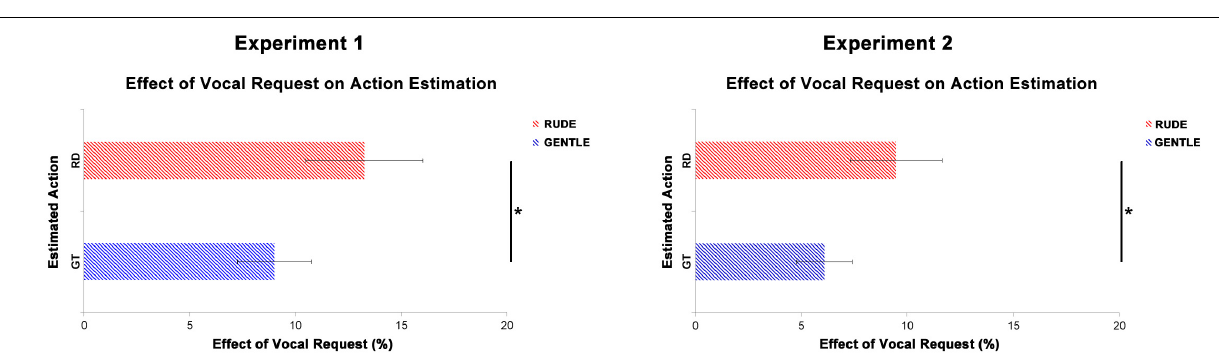
FIGURE 6 | Overall effect of gentle vocal requests on the estimation of rude (RD, red bars) actions duration and the overall effect of rude vocal requests on the estimation of gentle (GT, blue bars) actions duration. Graphs report standard errors (SE). * indicate statistical significance ( p < 0.05) in a paired sample t